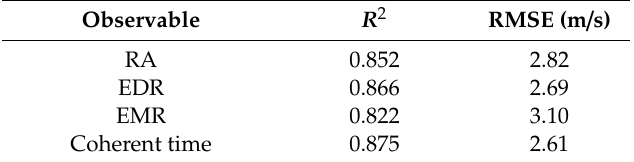
Figure 9. Scatter plots between in situ wind speed and observables during Typhoon UTOR. ( a ) RA . ( b ) Coherent time. ( c ) EMR. ( d ) EDR. EMR and EDR are computed with Threshold 2 = 0.25. The red lines are the fitting curves. Table 4. Retrieval performances by different observables during Typhoon UTOR.